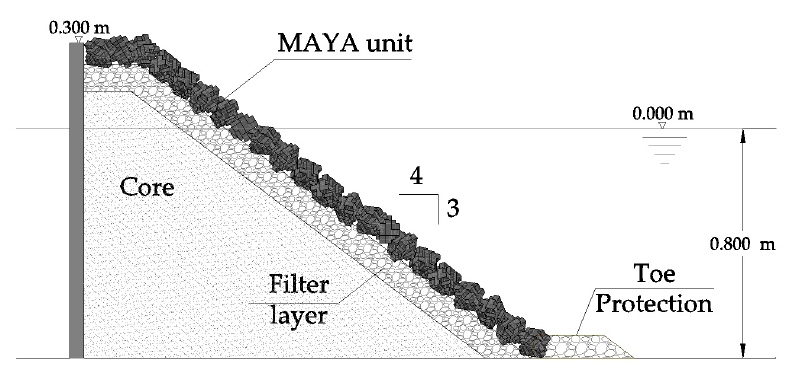
Figure 3. A cross section of the RMB model with MAYA mass